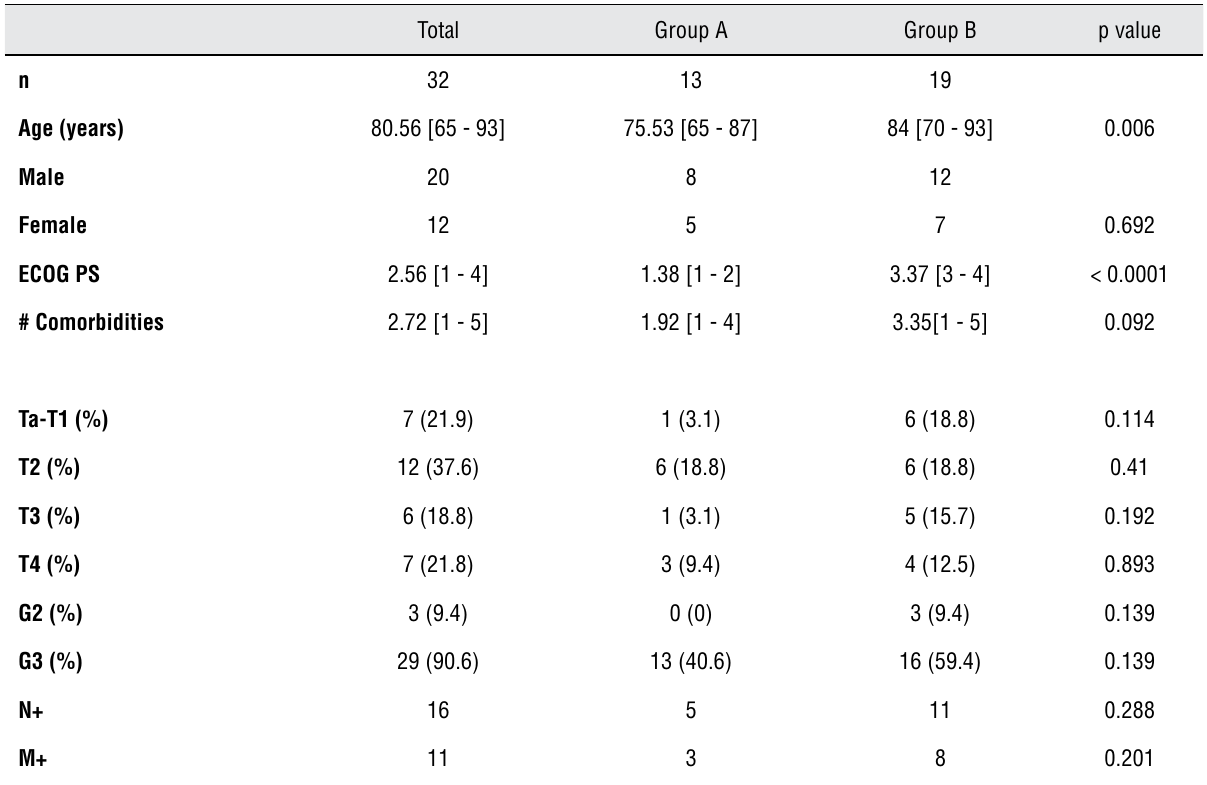
Table 1 - Patients’ characteristics.